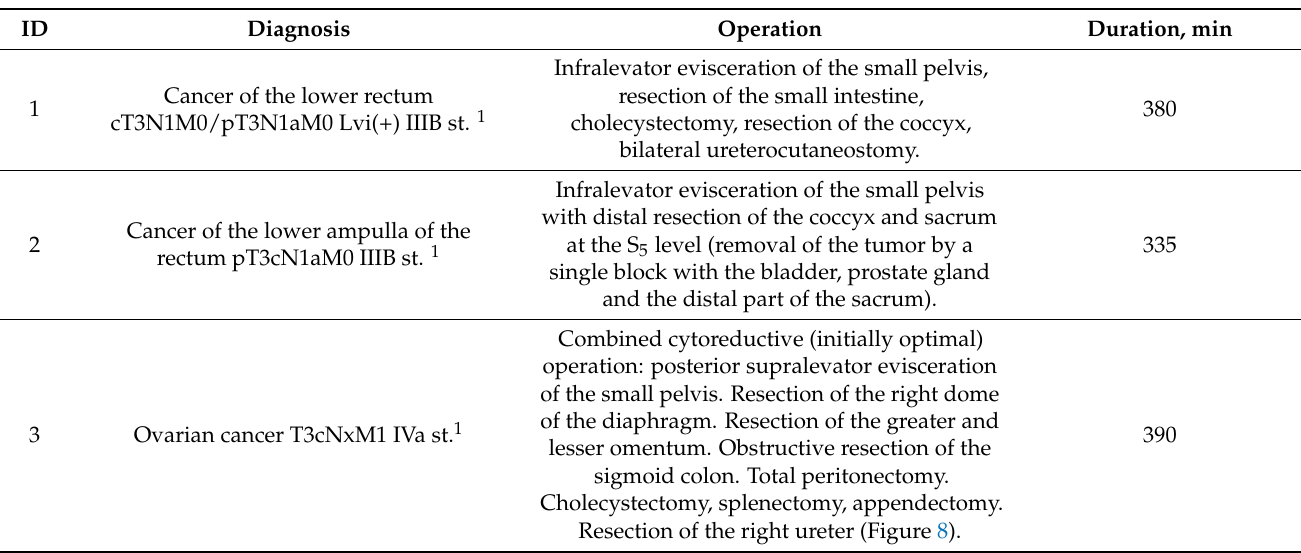
Table 1. Patients with invasive (pin) fixation of marks.